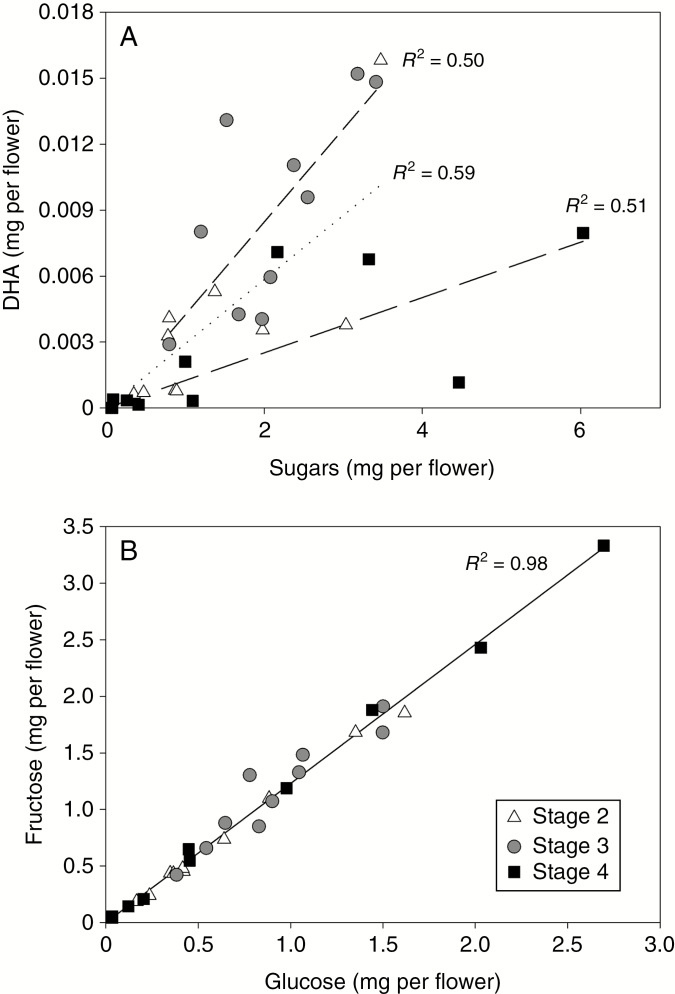
Relationships between (A) the amount of DHA per flower and fructose plus glucose per flower and (B) quantities of fructose and glucose per flower, for nectar harvested from mānuka genotype MI for floral stages 2–4.